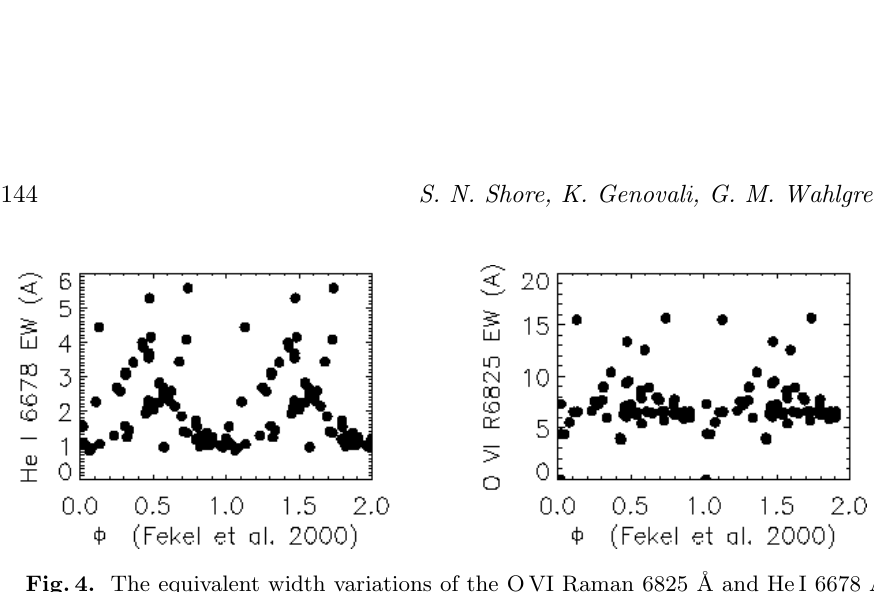
Fig. 4. The equivalent width variations of the O VI Raman 6825 ˚A and He I 6678 ˚A emission lines in AG Dra, corrected for continuum variations, phased on the orbital solution by Fekel et al. (2000). See text for